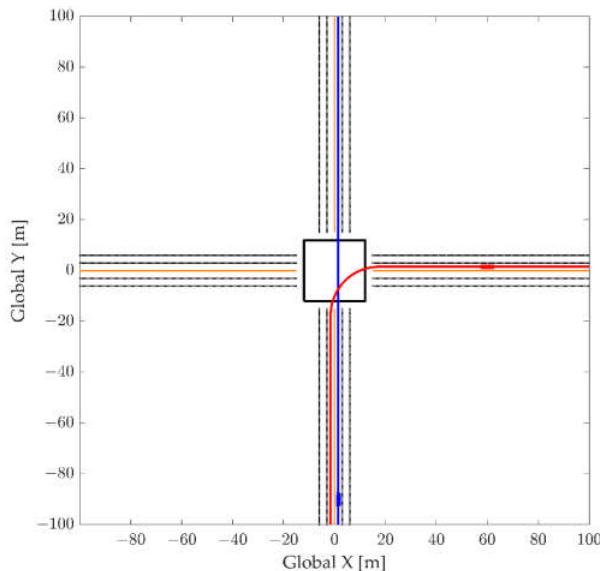
Figure 6. Initial conditions for simulation based on left turn across path scenario.